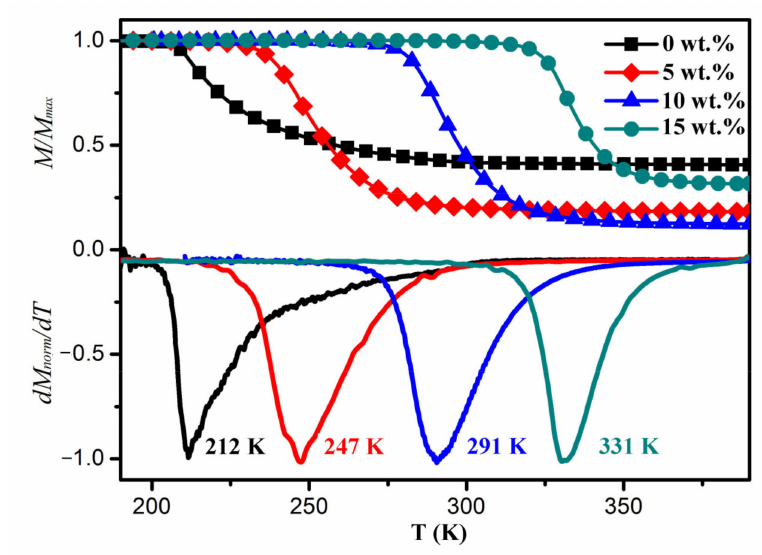
Figure 5. Normalized M/M max –T and dM norm /dT – T curves of LaFe 11.6 Si 1.4 / x wt.%Ce 2 Co 7 ( x = 0, 5, 10, and 15) composites sintered at 1373 K for 6 h upon cooling under an applied field of 0.05 T. Another parameter called RCP (Relative Cooling Power) can be employed to evaluate the refrigeration efficiency. RCP was defined as the product of ( − ∆ S M ) max times the full temperature width at half maximum of the peak (RCR = ( − ∆ S M ) max × δ T FWHM ) [54]. The values of T C , ( − ∆ S M ) max and RCP of the studied composites are presented in Table 2.